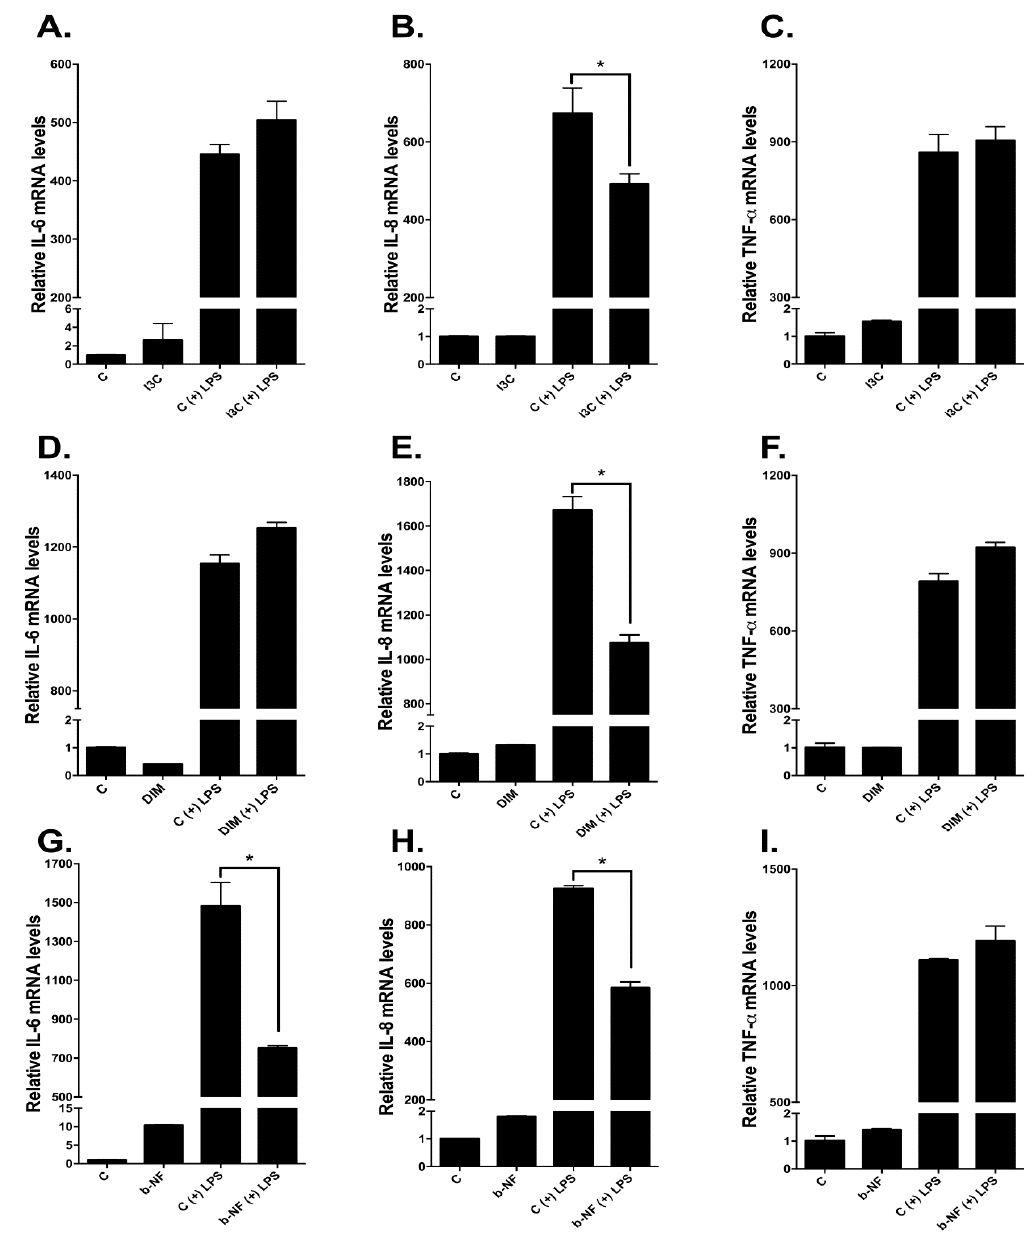
Figure 8. Effects of I3C, DIM and b-NF on LPS-inducible cytokines IL-6, IL-8 and TNF- α mRNA levels in u-THP-1 cells. U-THP-1 cells were treated with or without I3C (25 µ M), DIM (10 µ M) or b-NF (10 µ M) as described in Materials and Methods. After treatment with the compounds, cells were exposed to LPS for an additional 2 h. After LPS treatment, total RNA was isolated and IL-6, IL-8 and TNF- α mRNA expression were determined using RT-PCR. ( A – C ): Effects of I3C on IL-6 ( A ), IL-8 ( B ) and TNF- α ( C ); ( D – F ): Effects of DIM on IL-6 ( D ), IL-8 ( E ) and TNF- α ( F ); ( G – I ): Effects of b-NF on IL-6 ( G ), IL-8 ( H ) and TNF- α ( I ). Results are expressed as mean ± SD ( n = 3). * indicates significant difference from vehicle control at p ≤ 0.05.